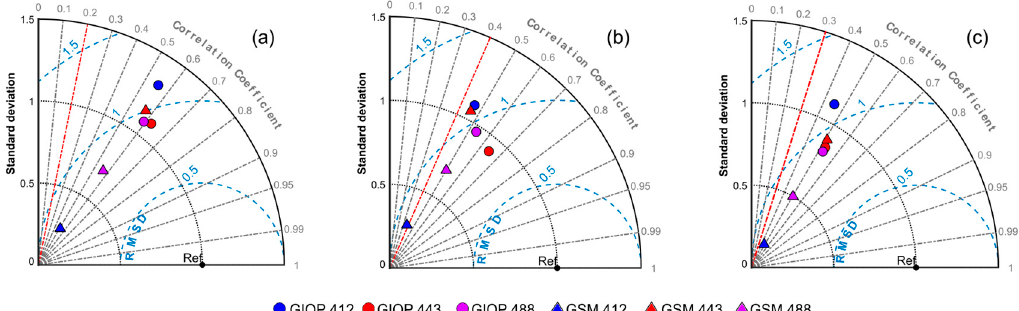
Figure 4. Taylor diagram illustrating the relative performance of the GIOP and GSM algorithms upon reproducing the absorption coefficient a ph (412, 443, and 488 nm). Diagrams represent ( a ) the entire dataset and data collected in the ( b ) UGC and ( c ) NGC. The red line represents the critical value of Pearson’s correlation coefficient and indicates the best-model performance.